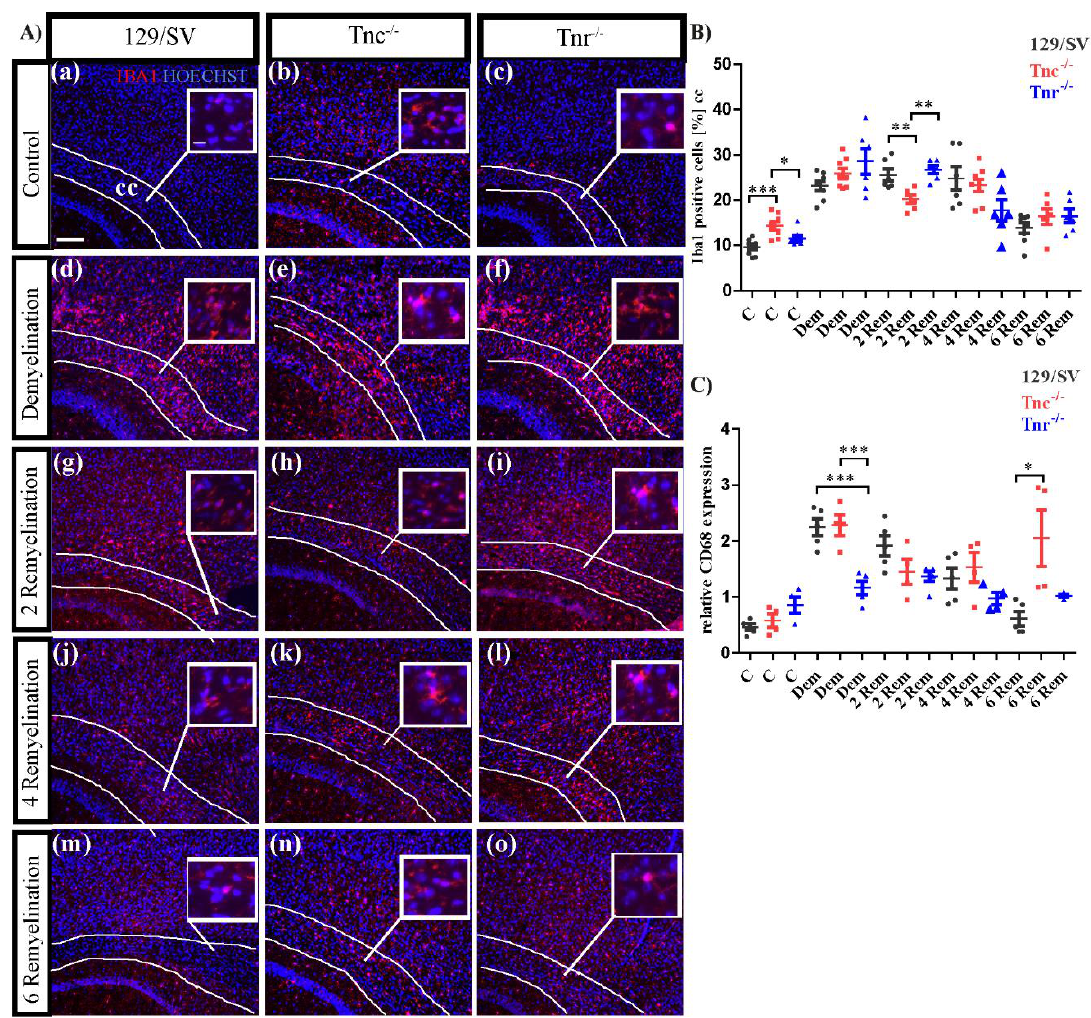
Figure 8. Activation of microglia upon cuprizone treatment. ( A ( a – o )) Sagittal sections of cuprizone- treated mice were immunohistochemically stained with an antibody against Iba1 to detect microglia (red color). Hoechst was used as a marker for cell nuclei. Five different conditions were analyzed: control (C), demyelination (DM), 2-, 4- and 6 weeks of remyelination (RM2, RM4 and RM6). Images show the caudal part of the corpus callosum (CC) above the hippocampus (HC), circle triangle squares show a better visualization of the cells. Significantly more Iba1 positive cells were detected in Tnc −/− and Tnr −/− mice ( A ( a – c ), B ). During demyelination, the number of Iba1 positive cells was strongly increased in comparison to the control and in the absence of Tnr the number of microglia was significantly increased ( A ( d – f ), B ). After 2 weeks of remyelination the number of Iba1 positive cells was decreased in Tnc −/− mice ( A ( g – i ), B ). This effect contrasts with the results of the latest stage of remyelination after 6 weeks where the number of Iba1 positive cells was significantly increased in Tnc −/− mice ( A ( m – o ), B ). RT-PCR analysis of CD68 to monitor the expression pattern of activated microglia was carried out. In the absence of Tnr, more activated microglia were present in the con- trol condition ( A ( a – c ), C ). In contrast, the CD68 expression during demyelination seemed reduced in Tnr −/− ( A ( d – f ), C ). In the absence of Tnr the expression of CD68 was limited and even during de- myelination and the first two remyelination stages (2 and 4 weeks) the expression increased only minimally ( A ( g – o ), C ). After 6 weeks of remyelination, the highest CD68 expression was measured in Tnc −/− . Data are presented as mean ± SEM and statistical significance ( p ≤ 0.05 *, p ≤ 0.01 **, p ≤ 0.001 ***) was assessed using the ANOVA and Tukey ’ s multiple comparison test for each group (control, demyelinated, remyelinated). Four independent experiments were performed (N = 4).